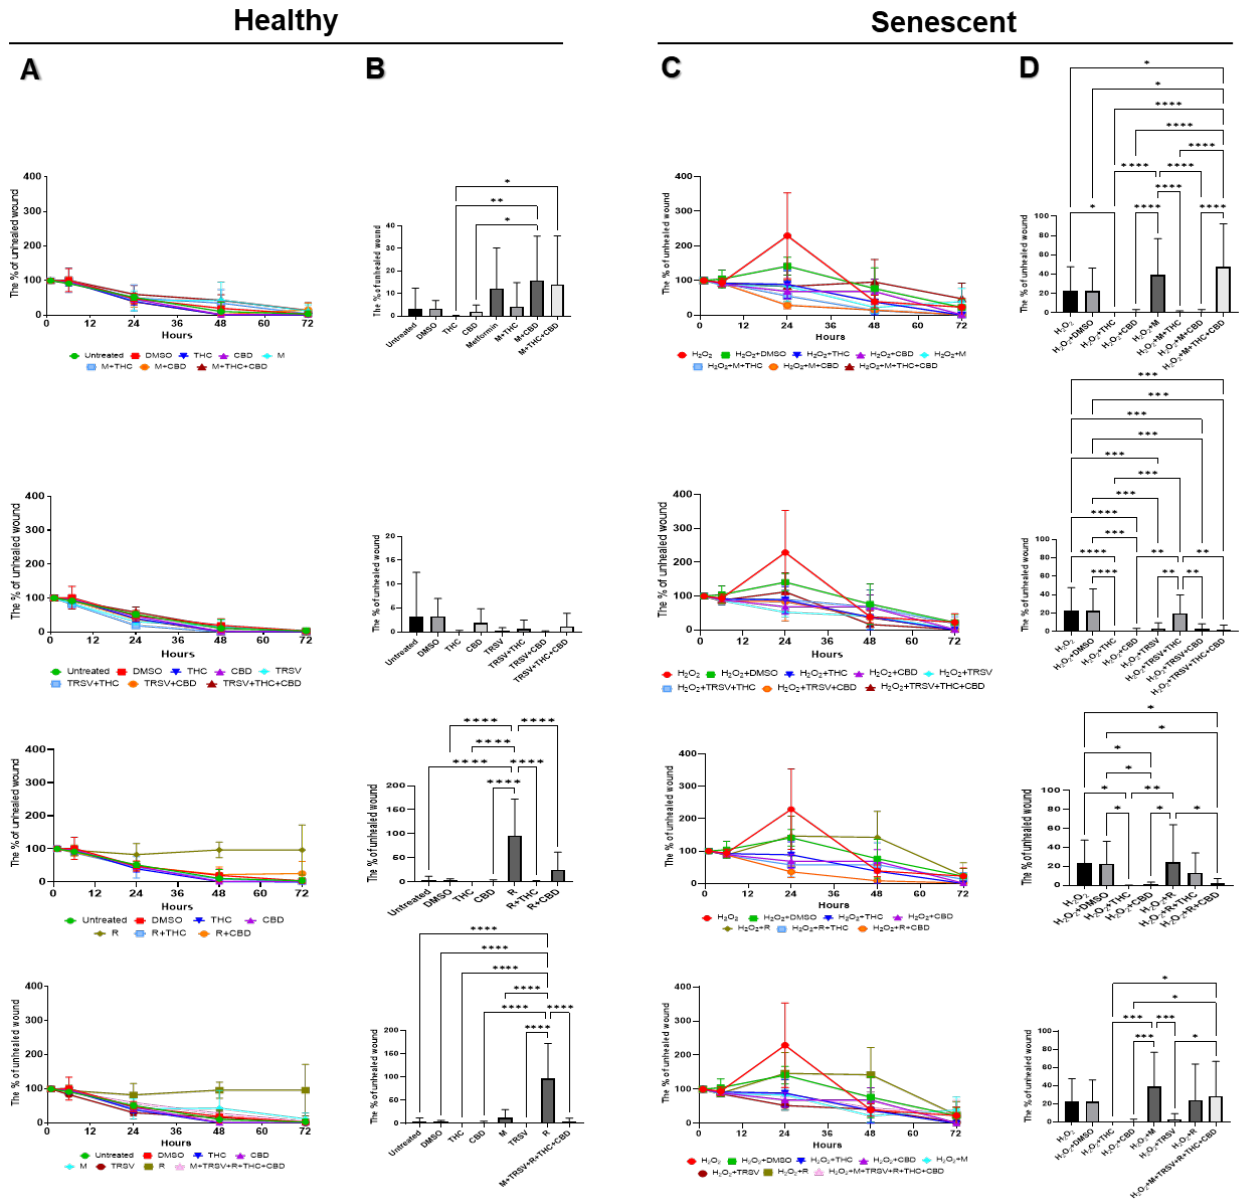
Figure 5. The effect of nutrient signaling regulators combined with phytocannabinoids on wound healing. Graphs represented wound healing assay results in CCD-1064Sk (p.11) dermal fibroblasts. ( A ) the percentage of an unhealed wound in healthy fibroblasts treated with metformin, TRSV and rapamycin combined with pCBs. ( B ) the percentage of the unhealed wound after 72 h of experiment in healthy cells with metformin, TRSV and rapamycin combined with pCBs. ( C ) the percentage of an unhealed wound in senescent fibroblasts culture treated with metformin, TRSV and rapamycin combined with pCBs. ( D ) the percentage of the unhealed wound after 72 h in prematurely aged fibroblasts metformin, TRSV and rapamycin combined with pCBs. Data were analyzed with a one- way ANOVA test followed by a Tukey post hoc multiple comparison test. Bars represent mean ± SD. Significance is indicated within the figures using the following scale: * p < 0.05, ** p < 0.01, *** p < 0.001, **** p < 0.0001. CBD, cannabidiol; DMSO, dimethyl sulfoxide (vehicle), M, metformin; R, rapamycin; THC, Δ -9-tetrahydrocannabinol; TRSV, triacetylresveratrol. As expected, fibroblasts exposed to hydrogen peroxide to induce SIPS had decreased wound healing after 72 h (Figures 4 and 5). Despite reported anti-aging properties of metformin, we found metformin exposure did not improve wound healing, and